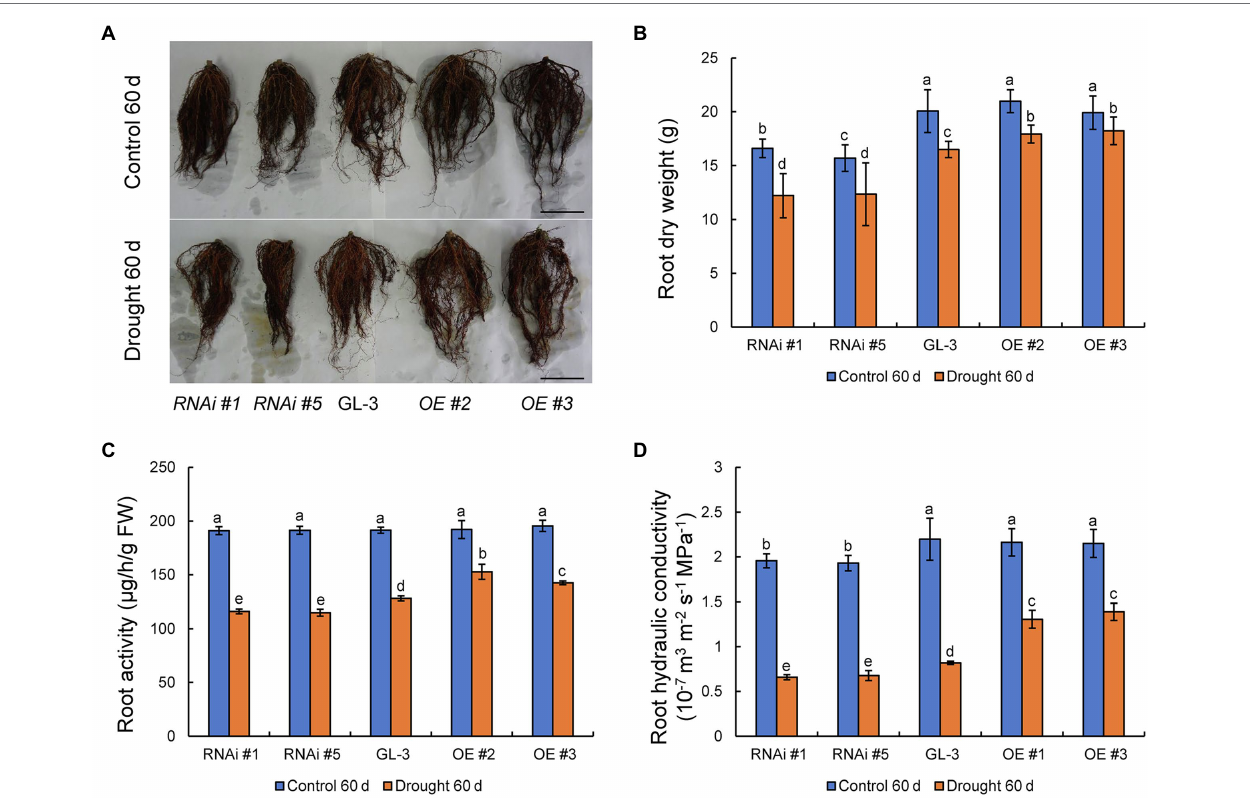
FIGURE 6 | Root growth and physiology of GL-3 and MdHB-7 transgenic apple plants under long-term moderate soil water deficit. (A) Root morphology. Scale bars, 5 cm. (B) Root dry weight. (C) Root activity measured by the TTC method. (D) Root hydraulic conductivity. Data are expressed as means ± SD ( n = 18 for B, 18 plants from each line; n = 3 for C, three biological replicates; n = 6 for D, six plants from each line). Within a sampling date, different letters indicate significant differences based on one-way ANOVA and Tukey’s multiple range test ( p <